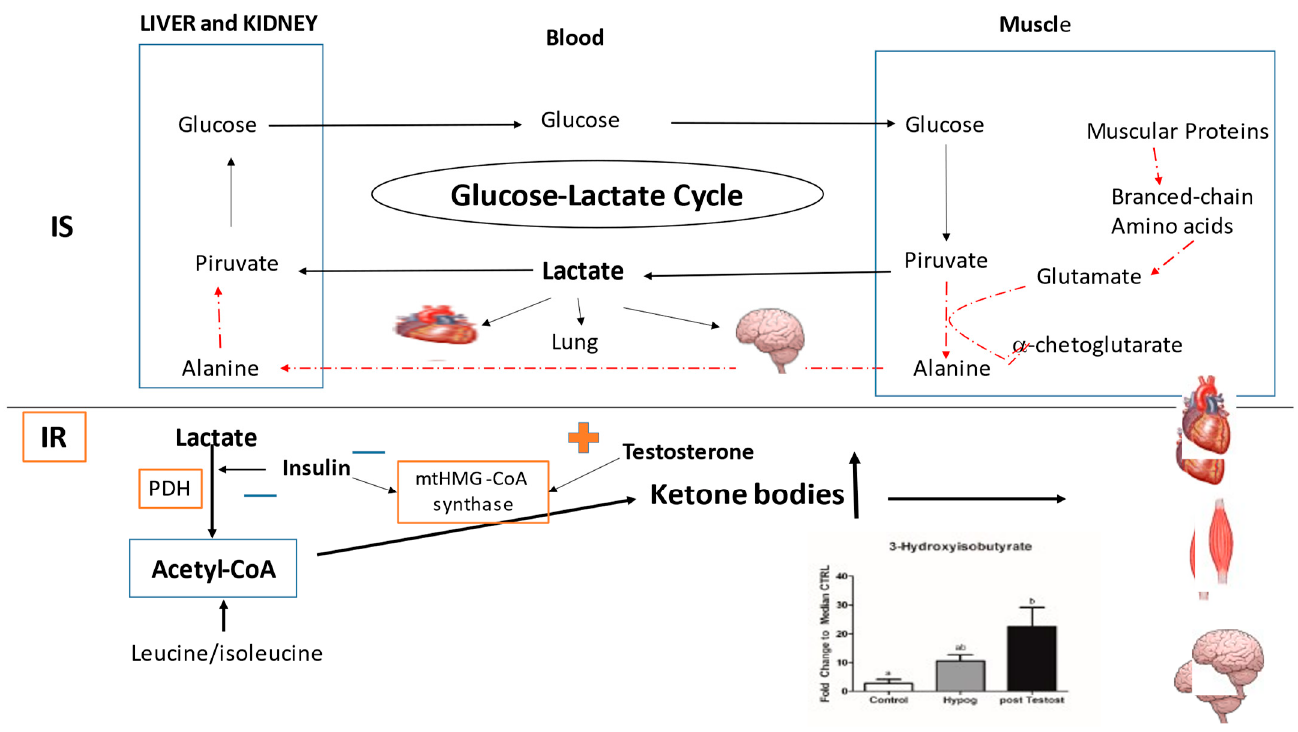
Figure 6. Summary of testosterone therapy effect on most metabolism pathways. The dashed and red lines indicate reduced metabolisms, while the solid lines indicate the positively influenced metabolisms. Arrows indicate increases or decreases.